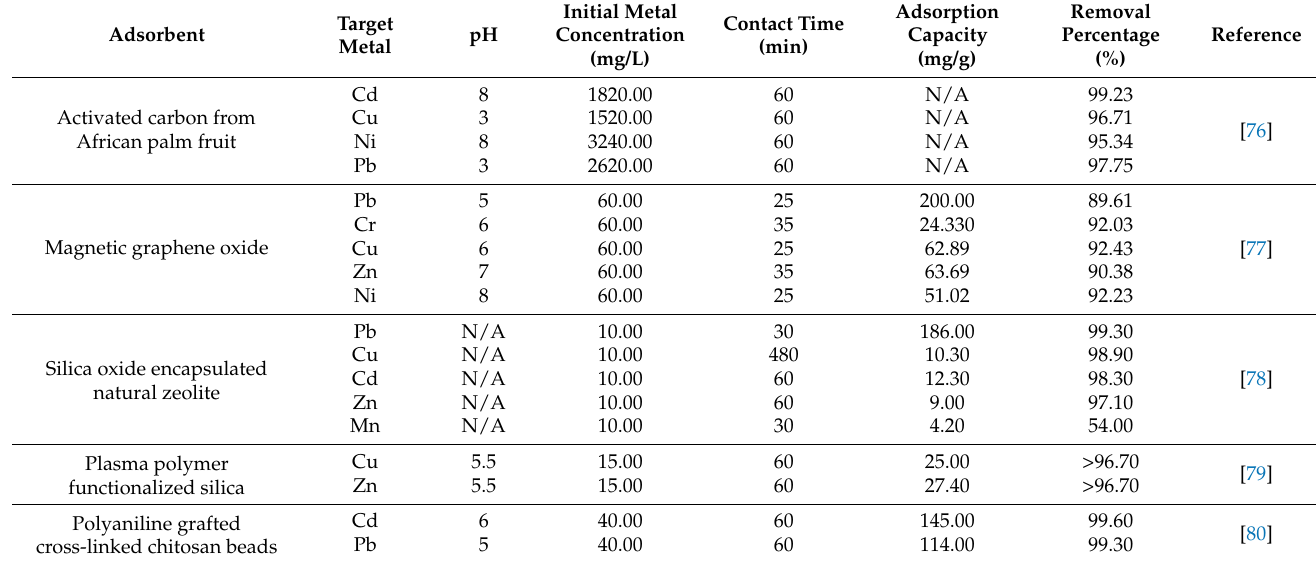
Table 14. The removal efficiency of several commonly used adsorbents toward heavy metals.